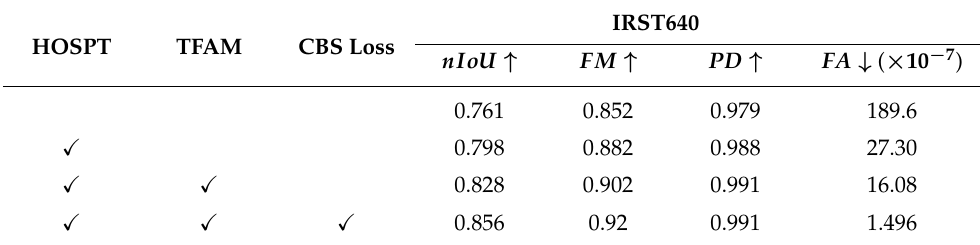
Table 3. The ablation study on the IRST640 dataset.